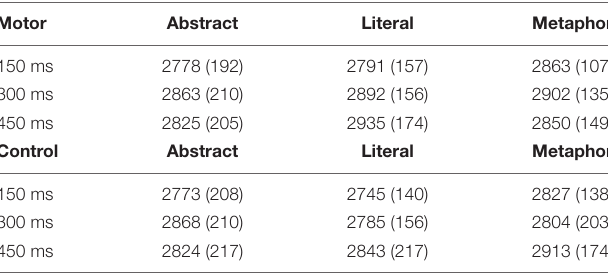
TABLE 1 | Mean (SD) RTs for each condition in each site of stimulation.